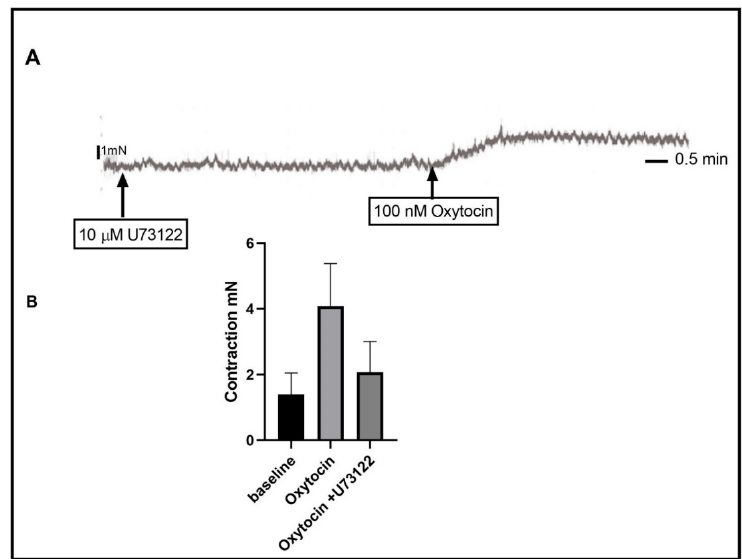
Figure 3. Effect of phospholipase C (PLC) inhibition on oxytocin-induced contraction. ( A ) is a representative trace demonstrating 100 nM oxytocin-induced contraction after 15 min of incubation with 10 µM of U73122. It also shows that U73122 did not affect the baseline activity. ( B ) is a graph summarizing the oxytocin-induced contraction after incubation with U73122. Data are expressed in mN of force. Values are mean ± SEM. n ≥ 35.